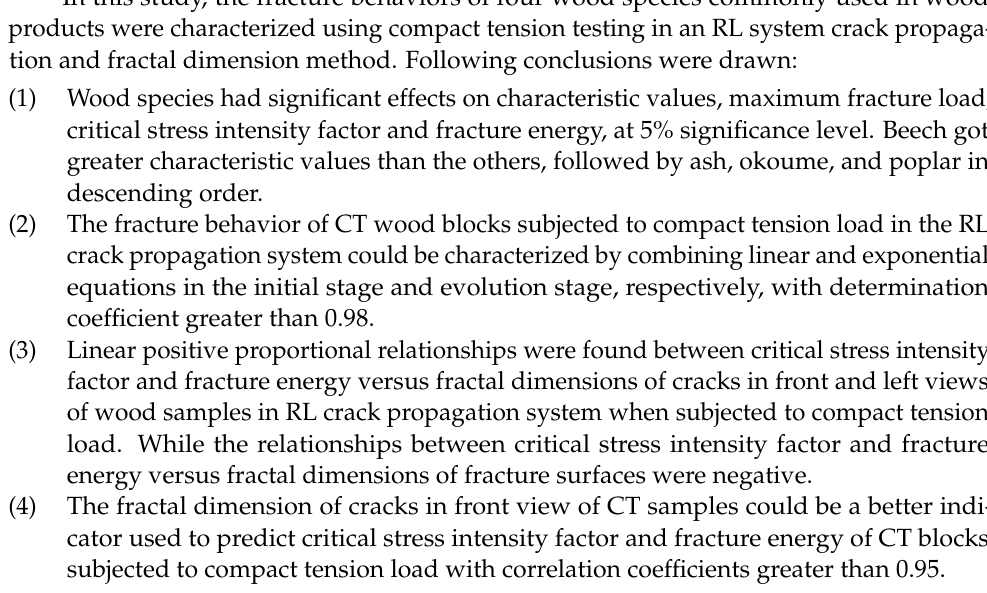
Table 5. Summaries of constants of equations for each of fitting lines of fracture characteristics versus fractal dimension of cracks. Fracture Fractal Dimension Characteristics of Crack Critical stress intensity